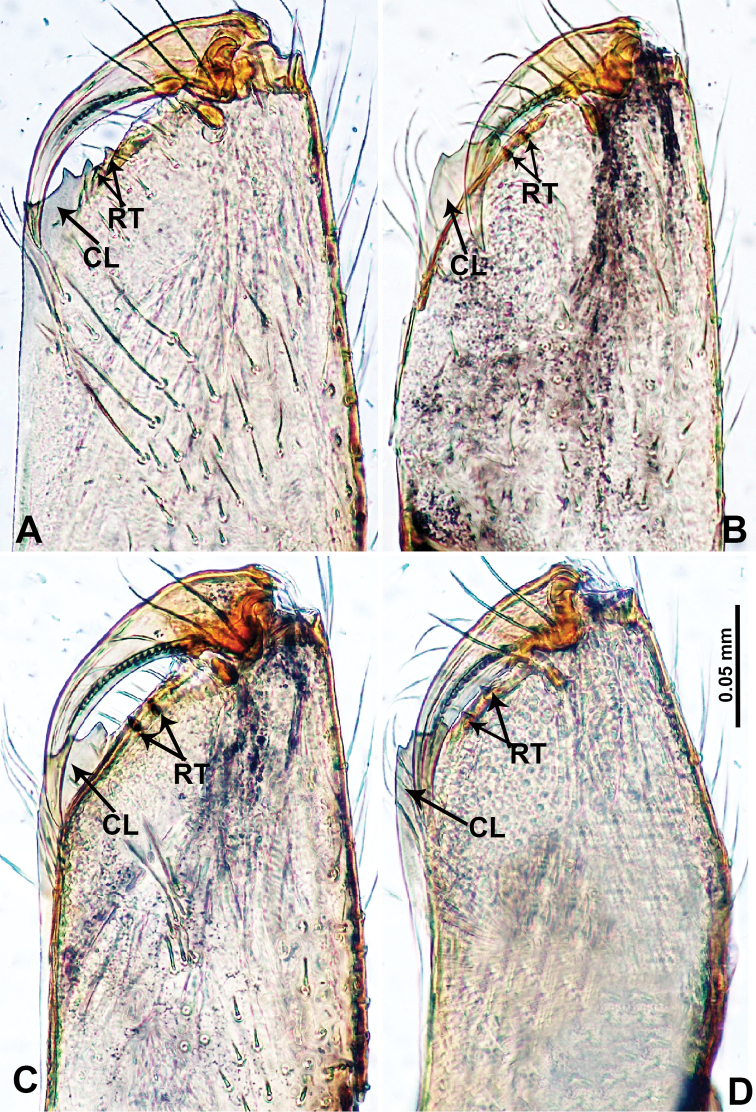
Cheliceral retromargin AQiongoceraluoxuan sp. nov. BRelictocerawugen sp. nov. CR.sigen sp. nov. DR.qianzi sp. nov. Abbreviations: CL = cheliceral lamina, RT = retromarginal teeth.